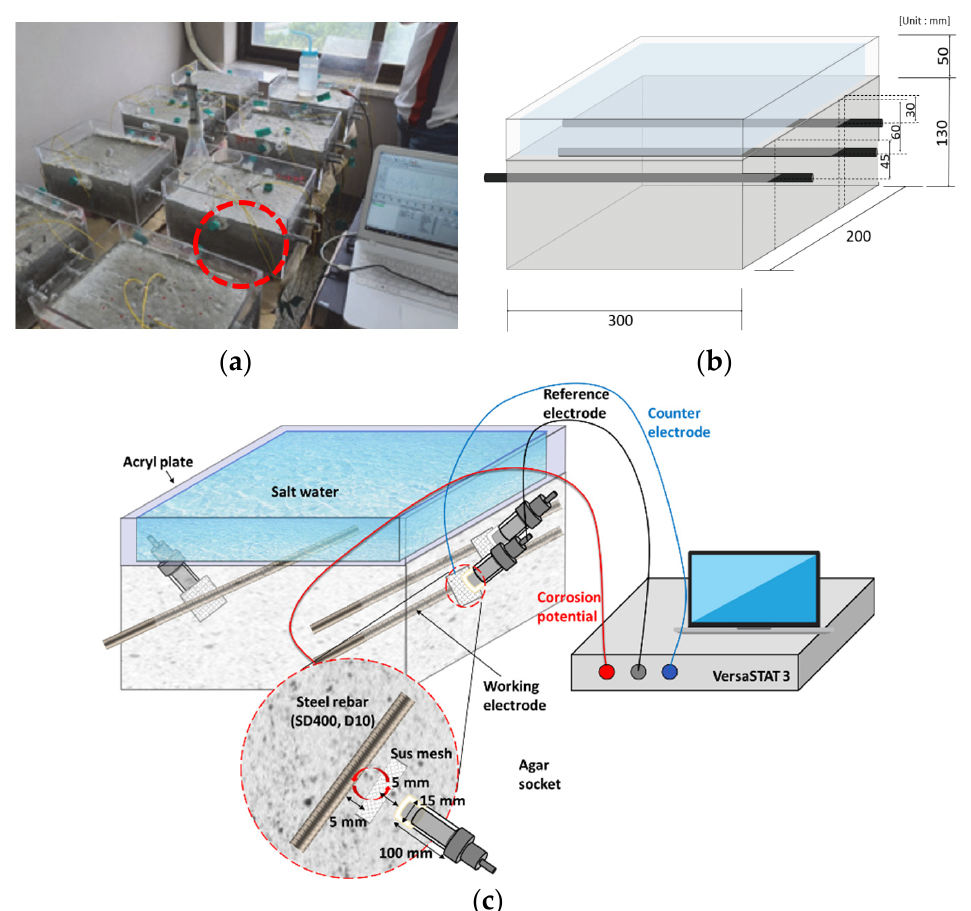
Figure 4. Photo and schematic diagram for RC samples for the test. ( a ) Photo of cured RC samples; ( b ) geometry of RC samples and ( c ) agar sensor installation and measurement connection.